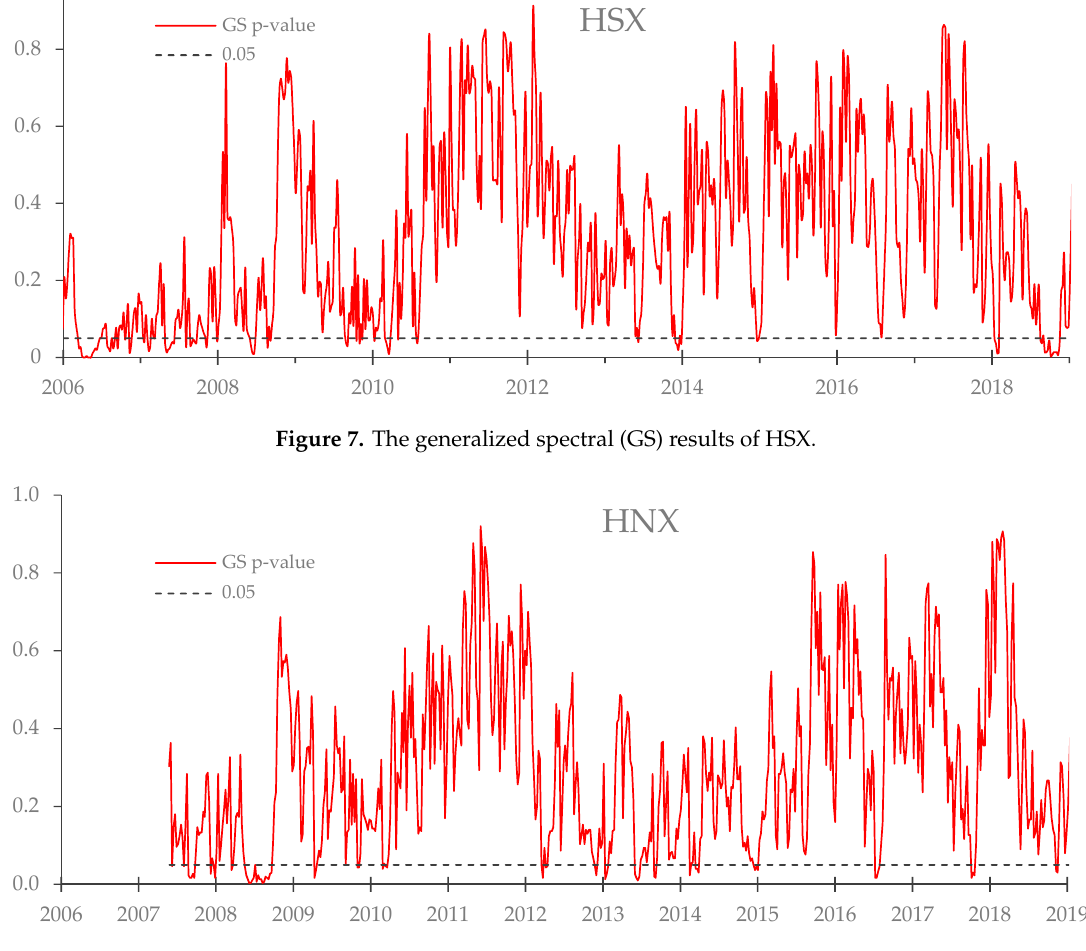
Figure 8. Results of HNX.